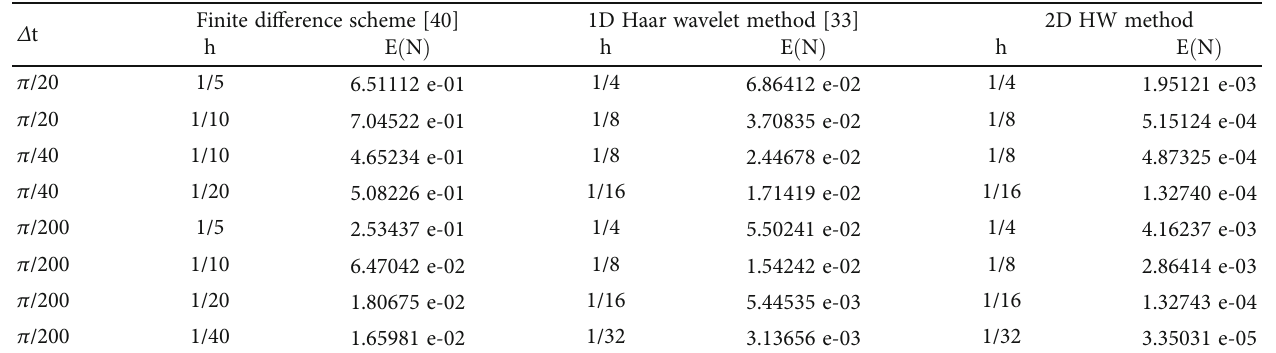
Table 1: Comparison of E ð N Þ with [33, 40] for Example